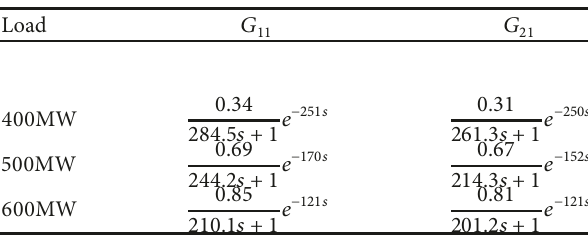
Table 1: The model of flue gas damper-reheat steam temperature under 400 MW, 500 MW, and 600 MW.